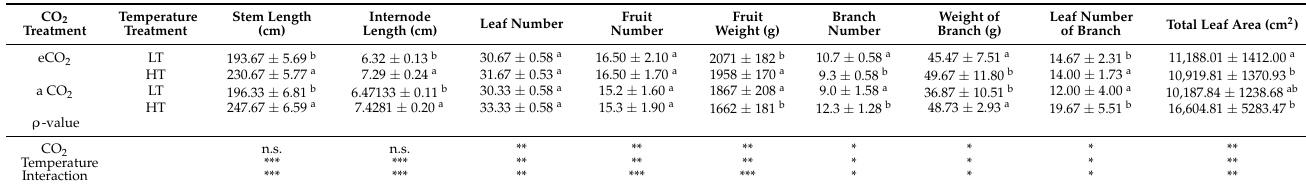
Table 1. Analysis of variance (ANOVA) of morphological parameters at harvesting under aCO 2 + LT, aCO 2 + HT, eCO 2 + LT, and eCO 2 + HT treatments. Data represent mean ± SE ( n =